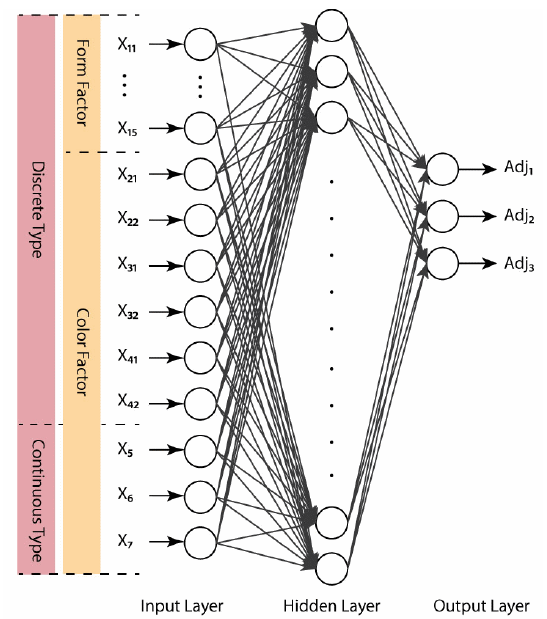
Appl. Sci. 2019 , 9 , x FOR PEER REVIEW Figure 2. Artificial neural network (ANN) model structure. Figure 2. Artificial neural network (ANN) model structure.